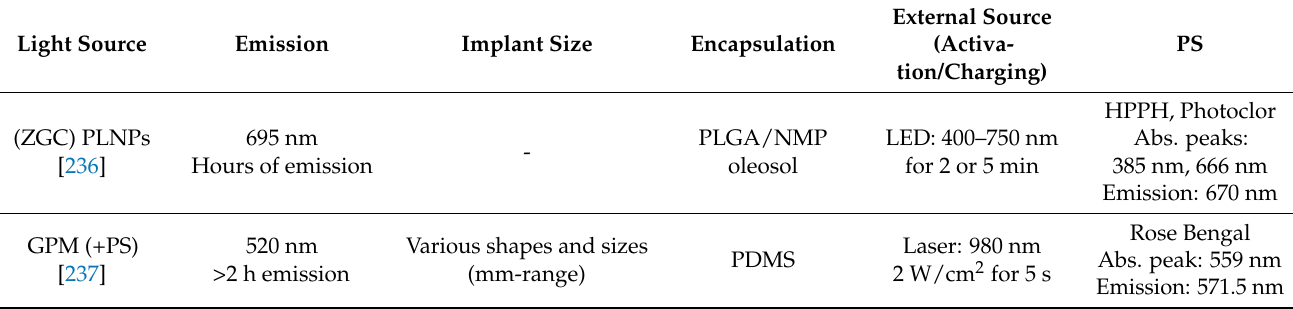
Table 5. Description of representative implants used for